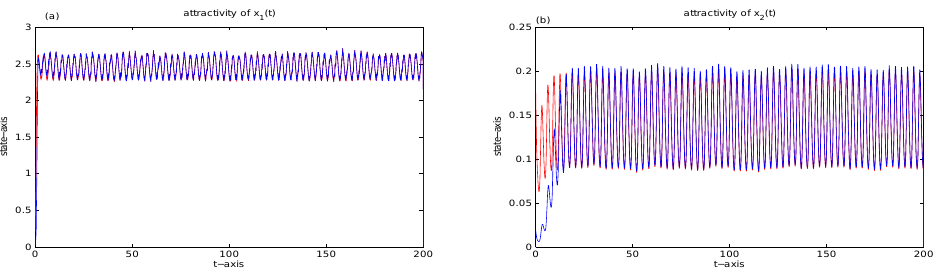
Figure 2. The attractivity of (2). The red lines are the time series of x 1 ( t ) and x 2 ( t ) with initial data x 1 ( 0 ) = x 2 ( 0 ) = 0.02, and the blue lines are the time series of x 1 ( t ) and x 2 ( t ) with initial data x 1 ( 0 ) = x 2 ( 0 ) = 2. ( a ) The attractivity of x 1 ( t ) ; ( b ) The attractivity of x 2 ( t )